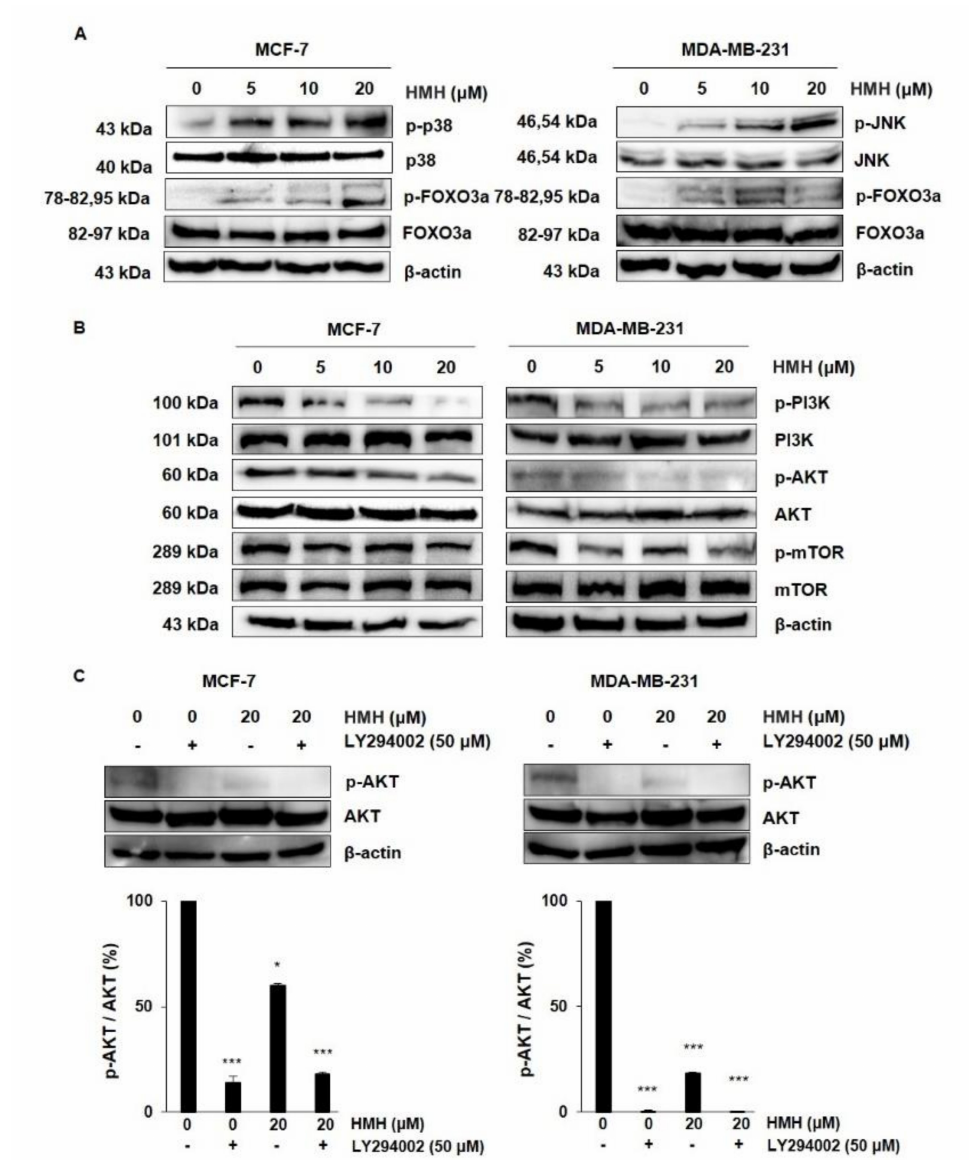
Figure 7. Action of harmine hydrochloride on MAPK and PI3K/AKT/mTOR signaling pathways in MCF-7 and MDA-MB-231 cells. ( A ) MAPK-associated protein expressions following treatment with harmine hydrochloride at 5, 10, and 20 µ M for 48 h in the MCF-7 and MDA-MB-231 cells are shown in the representative blots. ( B ) PI3K/AKT/mTOR signal-associated protein expressions following treatment with harmine hydrochloride at 5, 10, and 20 µ M for 48 h in MCF-7 and MDA-MB-231 cells are shown as representative blots. β -actin was used as an internal control. ( C ) Additionally, 0 or 20 µ M of harmine hydrochloride was applied in combination with the AKT inhibitor LY294002 to the MCF-7 and MDA-MB-231 cells to identify the p-AKT expression through western blot. Band intensity was normalized using the total AKT. Values indicate the mean ± SD. * p < 0.05 and *** p < 0.001, as shown by the Student’s t